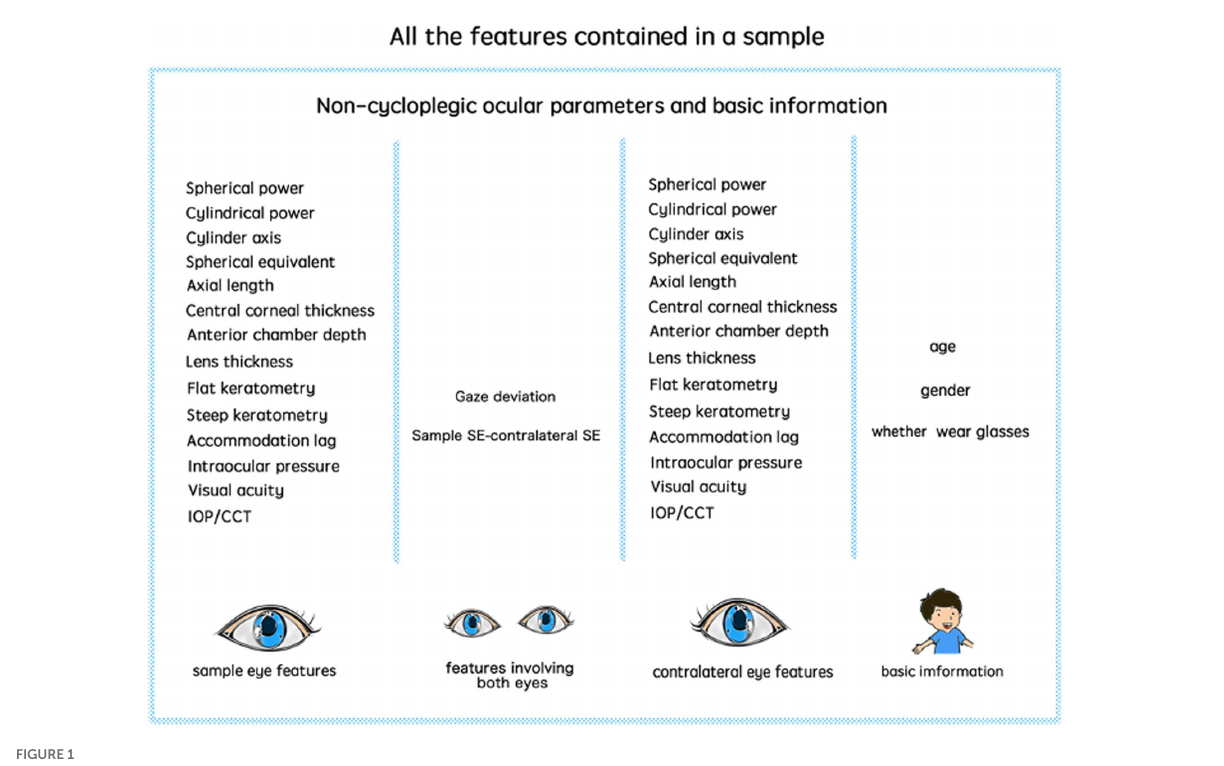
FIGURE 1 All the features contained in a